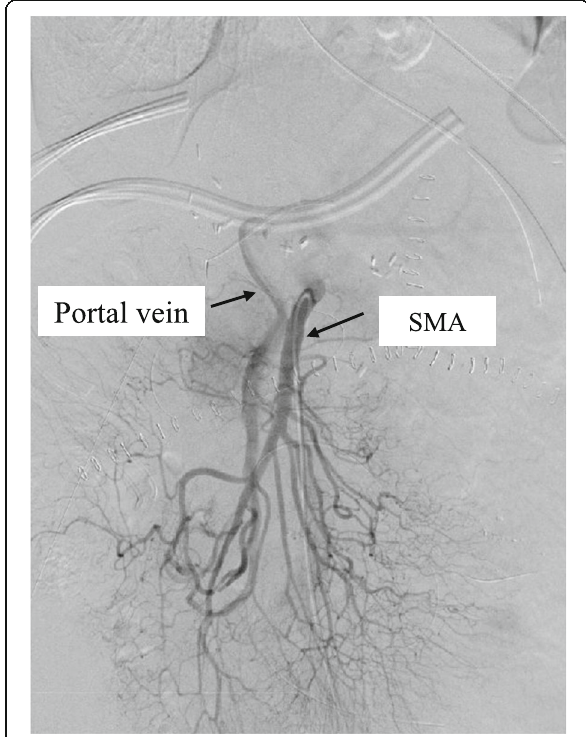
Fig. 2 Angiography of the superior mesenteric artery was performed on POD 3, showing a patent shunt and a clearly visible portal vein